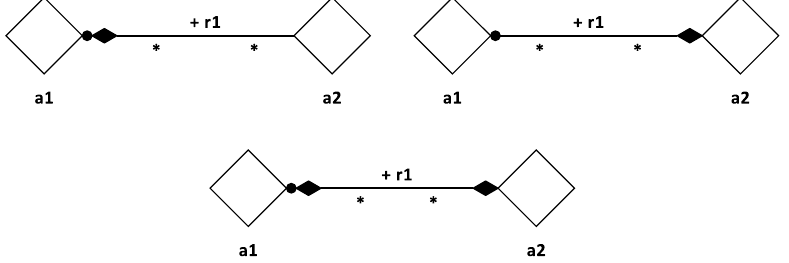
Fig. 12. Graphical representation of roles ( Role ) for a composition occurring on the side of the owner, direction and on both sides of the role ( Role ).